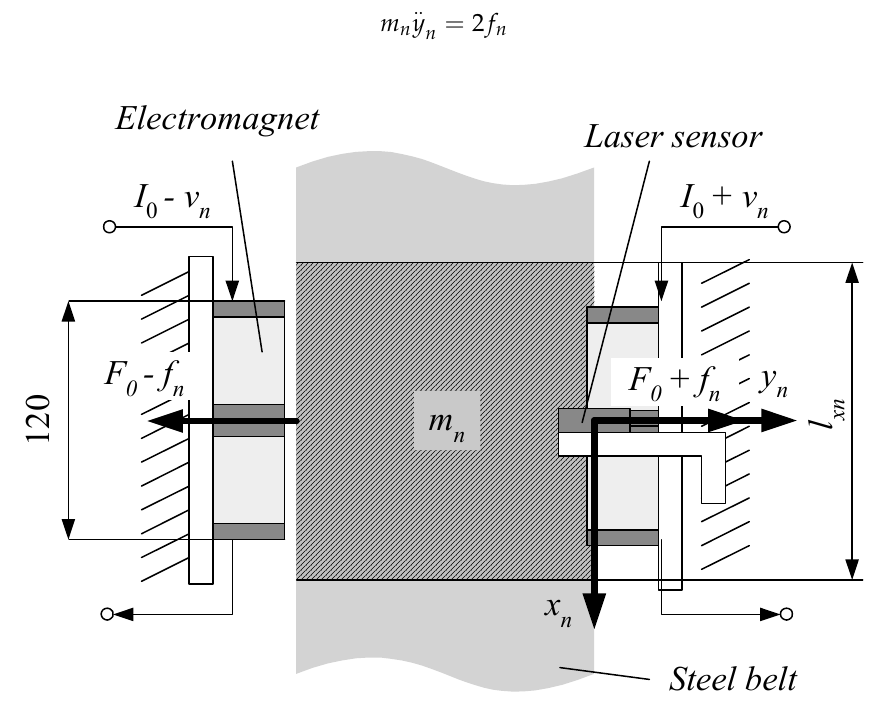
Figure 5. Model of noncontact guide.